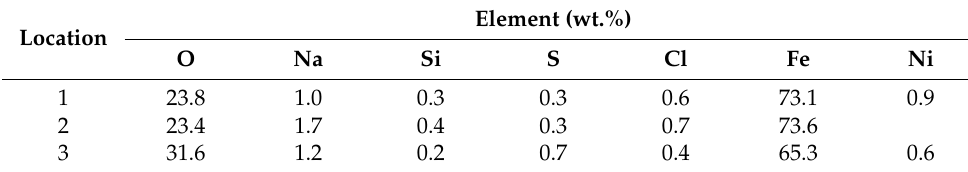
Table 6. Elemental analysis from locations in Figure 5.